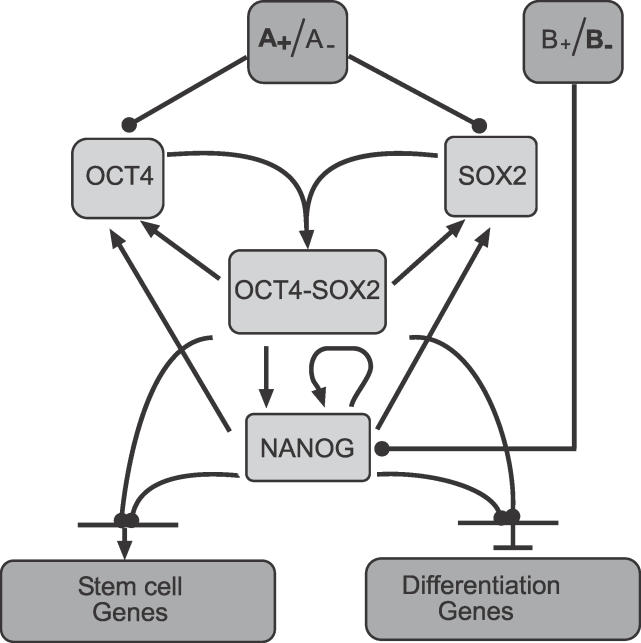
The Core Transcriptional Network of the ES CellGenes and proteins are represented as single entities. Each outgoing arrow represents a protein (the outgoing merging arrows from OCT4 and SOX2 represent complex formation). Each ingoing arrow represents a protein with a role as a TF. Signals A
+, e.g., the wnt signaling protein, triggers the system to sustain self-renewal and pluripotency, whereas signals B
−, e.g., p53, shuts it off, thereby leading to differentiation. It should be noted that there are also signals A
− that repress OCT4 and SOX2. These variants are not shown here since the effects will be similar to those of B
−. OCT4, SOX2, and NANOG individually as well as jointly target stem cell and differentiation genes. We model the set of TGs that are jointly regulated by OCT4, SOX2, and NANOG. The nature of the regulation at the TGs is not specified, since we explore all the possibilities. However, the final effect of the regulation is indicated.